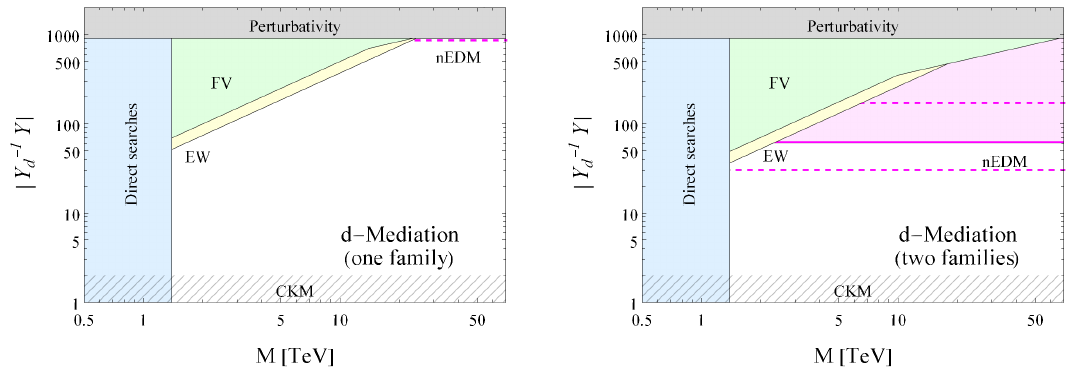
Figure 2 . Summary of the most relevant experimental constraints for models of d -mediation with one (left) or two (right) families of ψ, ψ c . We show direct searches in light blue, electroweak bounds in yellow (“EW”, see (3.5)), constraints from flavor violation in light green (“FV”, in particular those due to the ∆ F = 1 transitions discussed below (3.8) are visible at lower mass and the B s − B s mixing constraint imposed on C (1 − loop) dominates at larger M ), and the bound from the neutron electric dipole moment in magenta (“nEDM”) with a rough estimate of the error band (dashed lines). As seen in section 2.1.1, | Y − 1 Y | is also subject to a lower bound (see hatching), required d in order for these models to be able to reproduce the CKM phase, and an upper bound, from perturbativity (see the grey region). See the text for